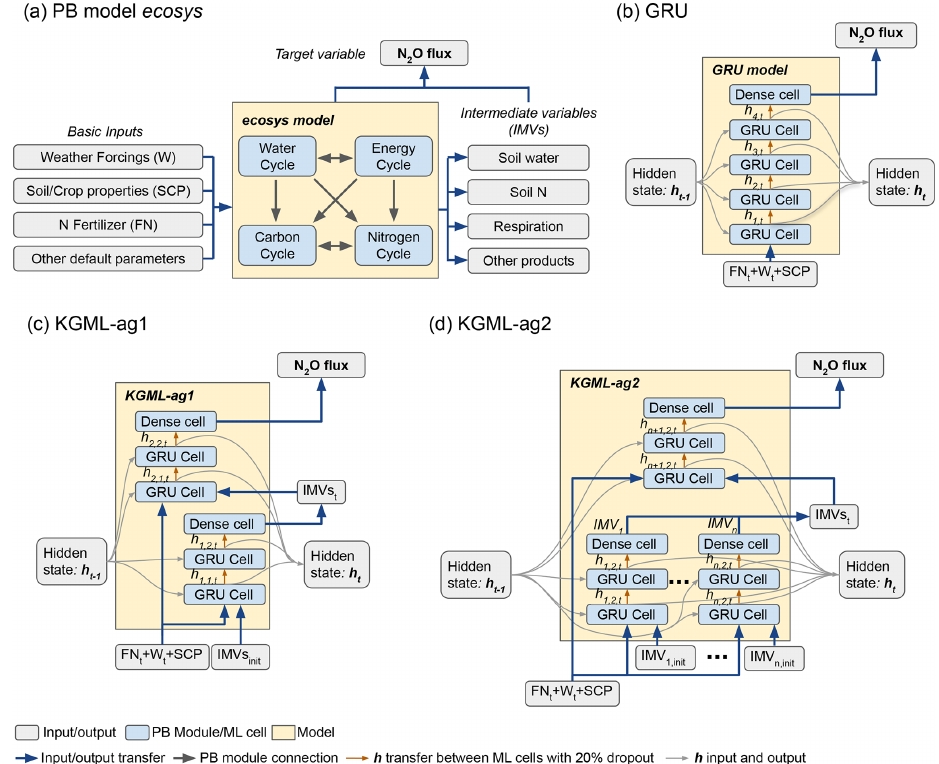
Figure 1. The model structures. (a) The ecosys model; (b) gated recurrent unit (GRU) model; (c) KGML-ag1 model with a hierarchical structure; (d) KGML-ag2 model with a hierarchical structure with separated GRU modules for IMV predictions. Specifically, in our KGML model design, weather forcings (W) include temperature (TMAX, TDIF), precipitation (PRECN), radiation (RADN), humidity (HMAX and HDIF) and wind speed (WIND); soil/crop properties (SCP) include bulk density (TBKDS), sand content (TCSAND), silt content (TCSILT), pH (TPH), cation exchange capacity (TCEC), soil organic carbon (TSOC), planting day of the year (PDOY) and crop type (CROPT); IMVs include CO 2 flux, soil NO 3 − concentration, soil NH 4 + concentration and soil volumetric water content